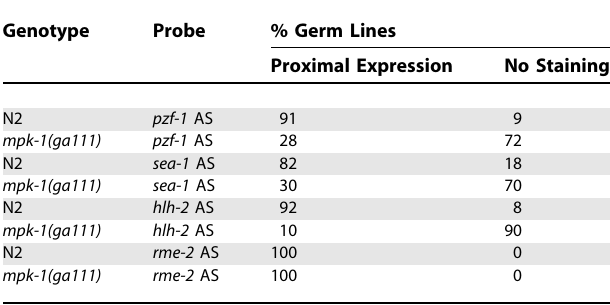
Table 2. In Situ Hybridization Analysis of Autosomal MPK-1 Signaling-Responsive